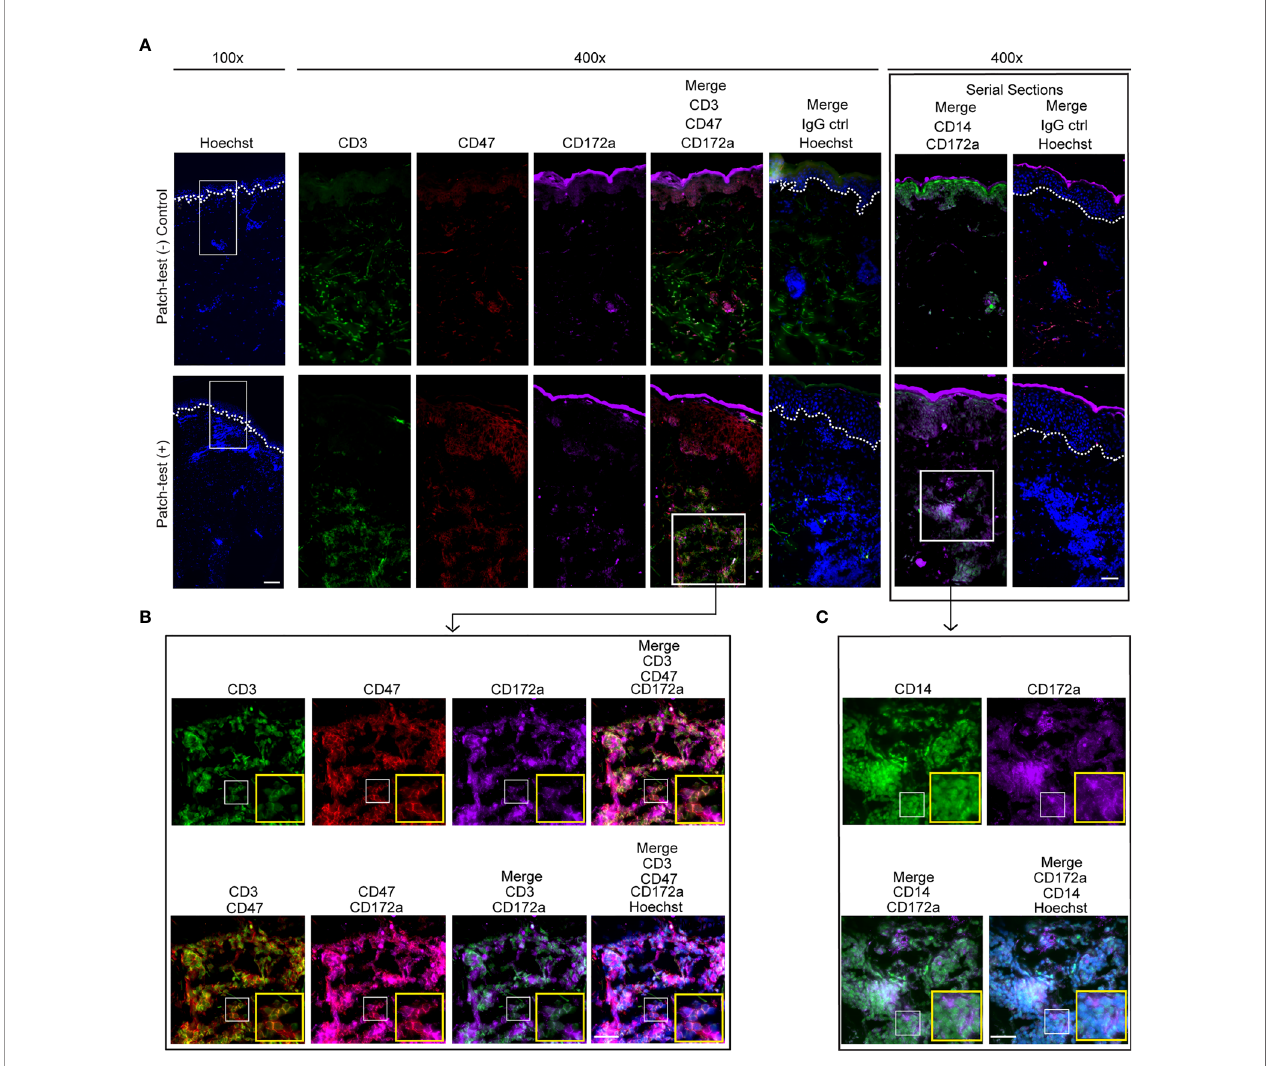
FIGURE 3 | CD3, CD47, and CD172a expression in human ACD clusters. (A – C) Immuno fl uorescence staining of CD3 (green), CD47 (red), CD172a (purple), CD14 [green, a serial slide section with the staining of CD172a (purple)], and Hoechst (blue) in human donor-matched patch-test negative control and patch-test (+) ACD skin. White dashed lines mark the epidermal-dermal junction. Data are representative of 3 patient samples per tested condition. (A) Scale bars are 200 µm (left) and 100 µm (right). (B, C) Scale bars are 20